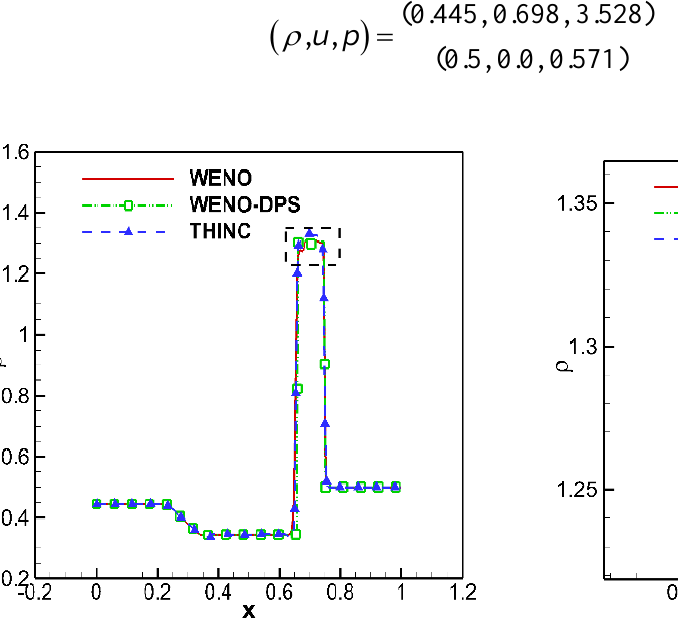
Figure 9. Density plot of Lax test case with Figure 10. Zoomed view of density plot of Lax